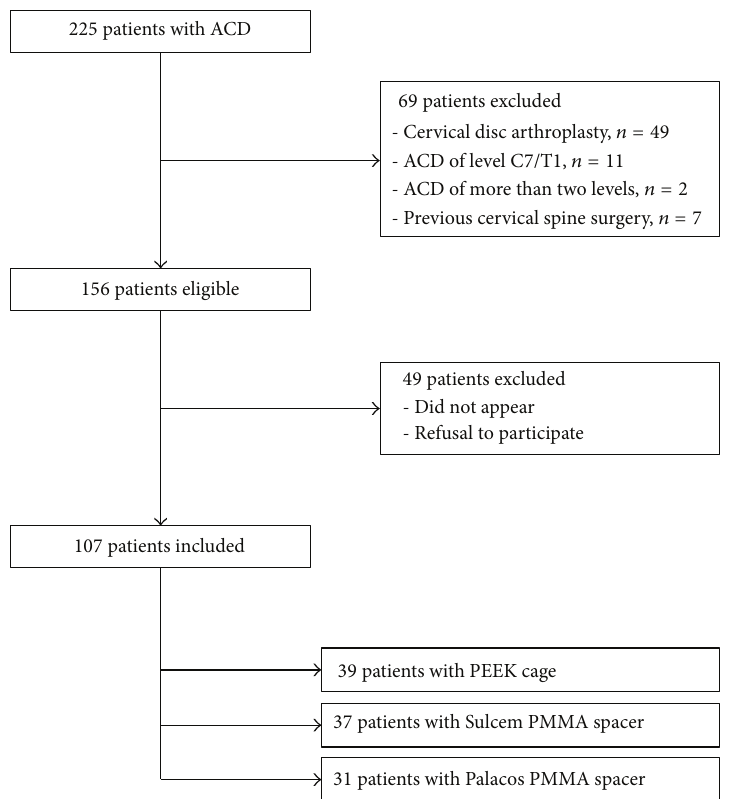
Figure 1: Patient flow diagram. Out of 225 patients with ACD between January 2005 and February 2009, 107 patients were included in one PEEK cage group and two PMMA groups. ACD: anterior cervical discectomy, PEEK: polyetheretherketone, and PMMA: